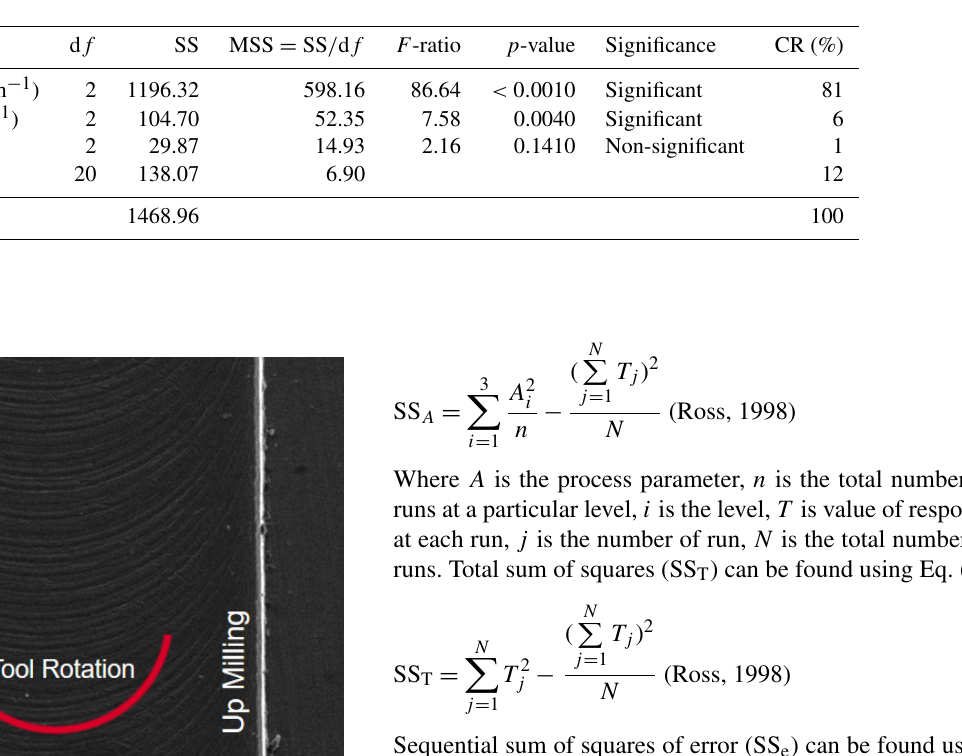
Table 7. ANOVA table for significance and contribution ratio of parameters (feed, speed and depth of cut).